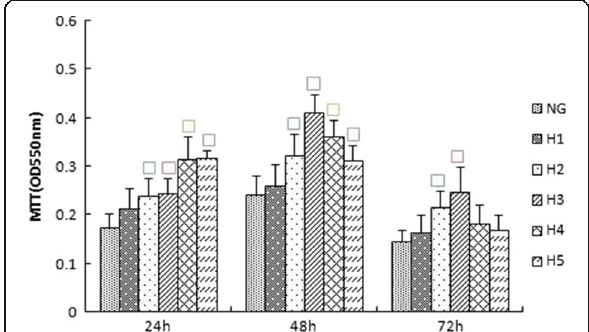
Fig. 1 Effects of different concentrations of glucose on the proliferation of rat glomerular mesangial cells at various time points (24 h,48 h,72 h).Proliferation was measured by MTT. NG:normal control group,H1:glucose concentration of 15 mmol/L,H2:glucose concentration of 25 mmol/L,H3:glucose concentration of 30 mmol/ L,H4:glucose concentration of 35 mmol/L,H5:glucose concentration of 50 mmol/L.Data are presented in mean ± SD, □ P < 0. 05 versus